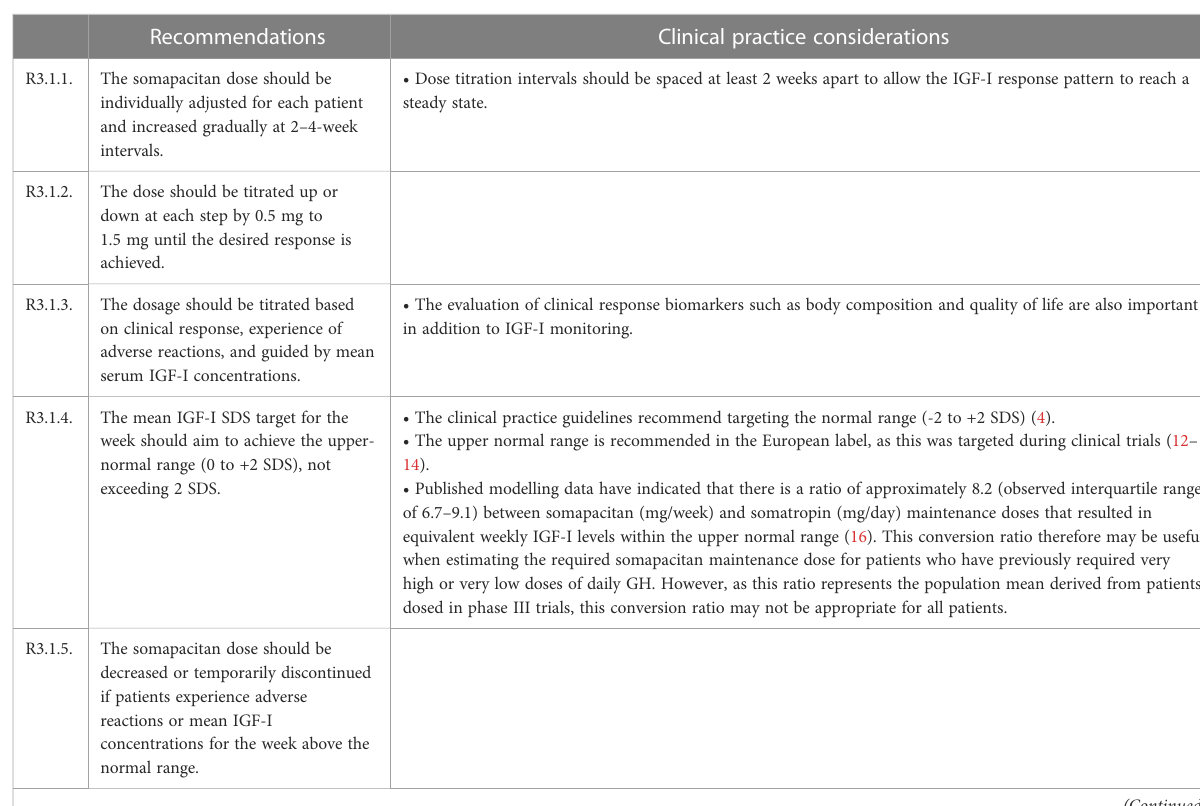
TABLE 3(A) Recommendations for IGF-I-guided dose titration and monitoring of AGHD patients treated with